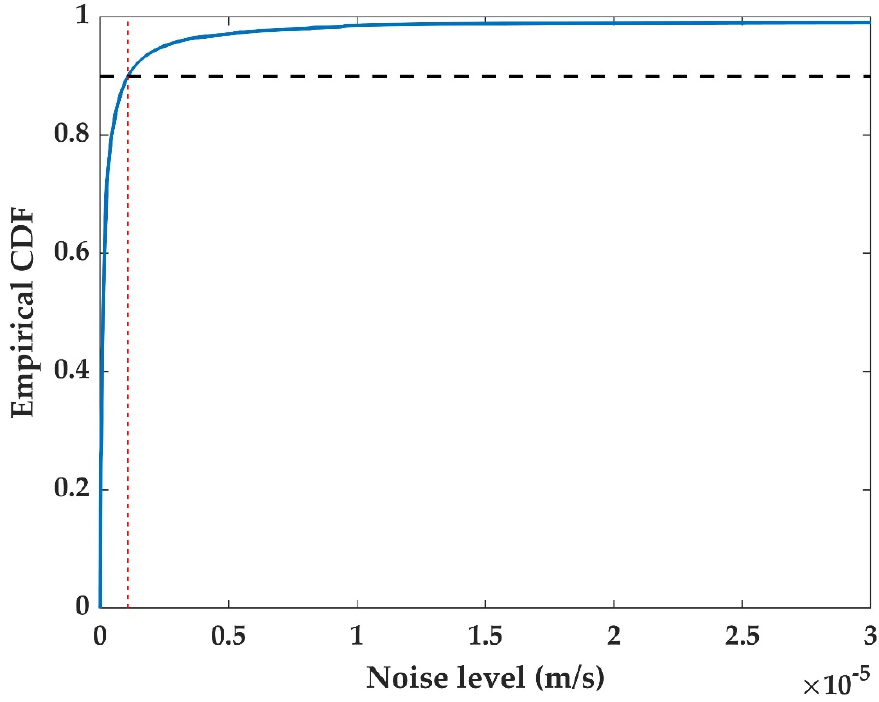
Figure 5. Empirical Cumulative Distribution Function (ECDF) of the noise distribution. The horizontal black dashed line marks the 0.9 level and the red dashed line intercepts the 90th percentile for the distribution.